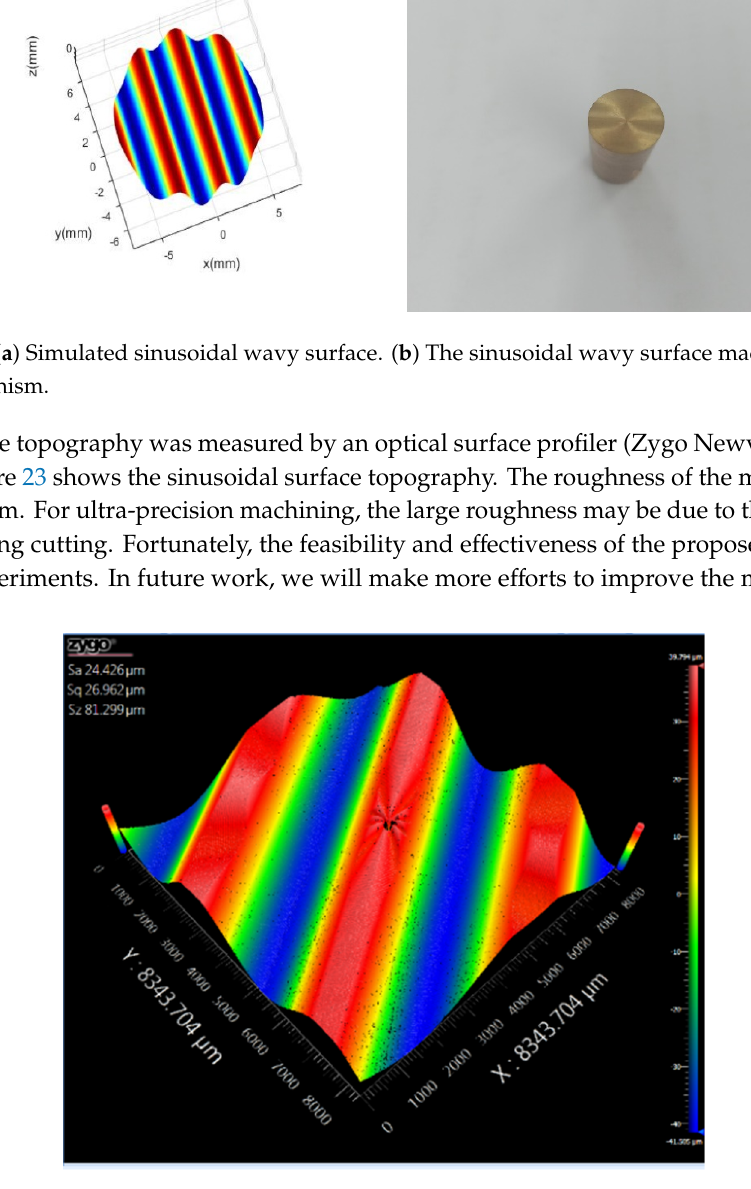
Figure 21. Experimental setup for the cutting.